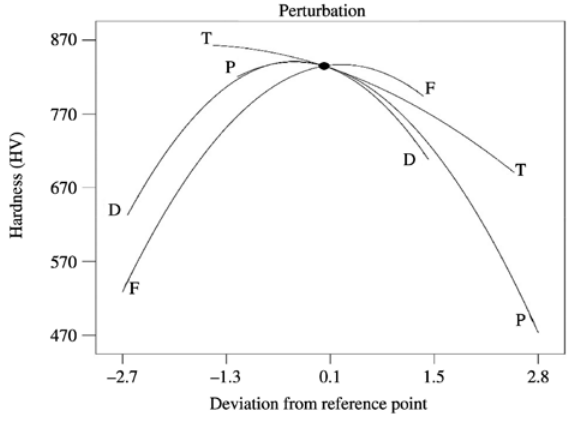
Figure 5: Perturbation